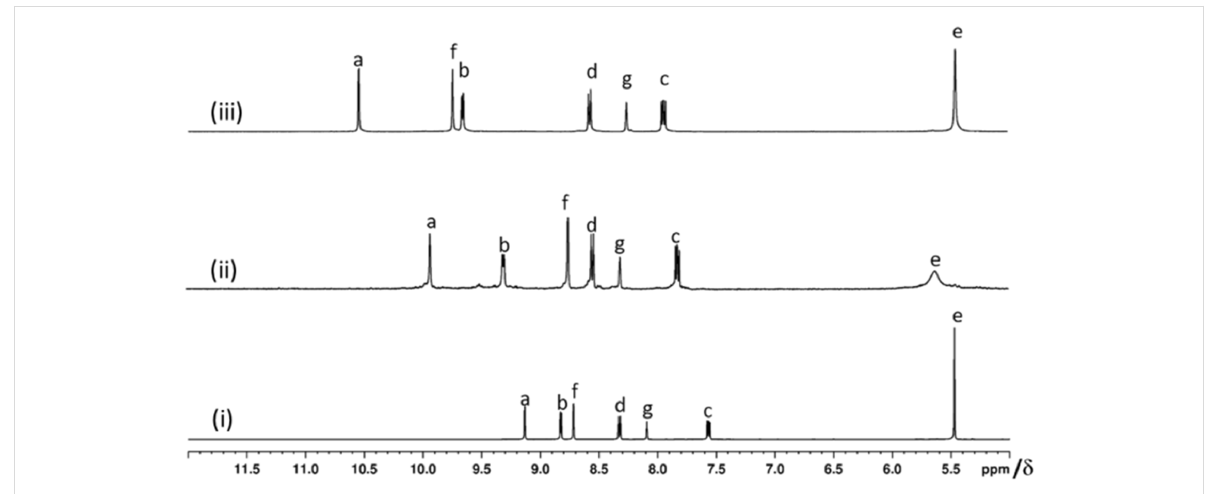
Figure 3: Partial 1 H NMR spectra in DMSO- d 6 for (i) L1 , (ii) [Pd( L1 ) 2 ](NO 3 ) 2 ( 3a ) and (iii) [(NO 3 ) 2 @Pd 3 ( L1 ) 4 ](NO 3 ) 4 ( 4a ).